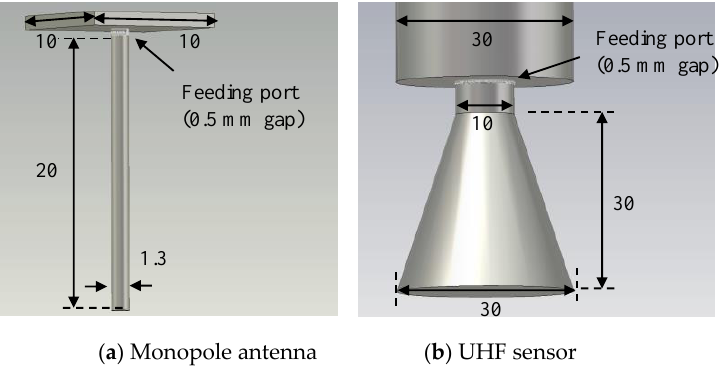
Figure 7. Modeling of the monopole and UHF sensors.